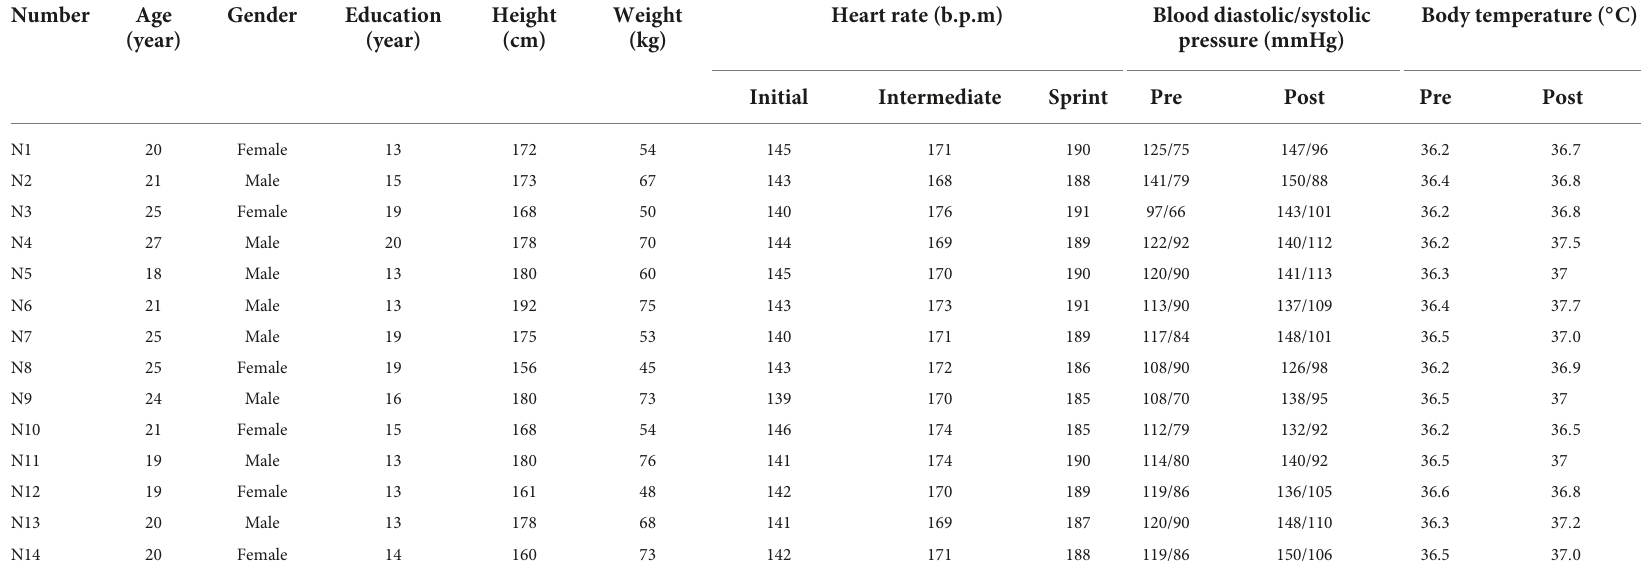
TABLE 2 Basic information of participants and behavioral